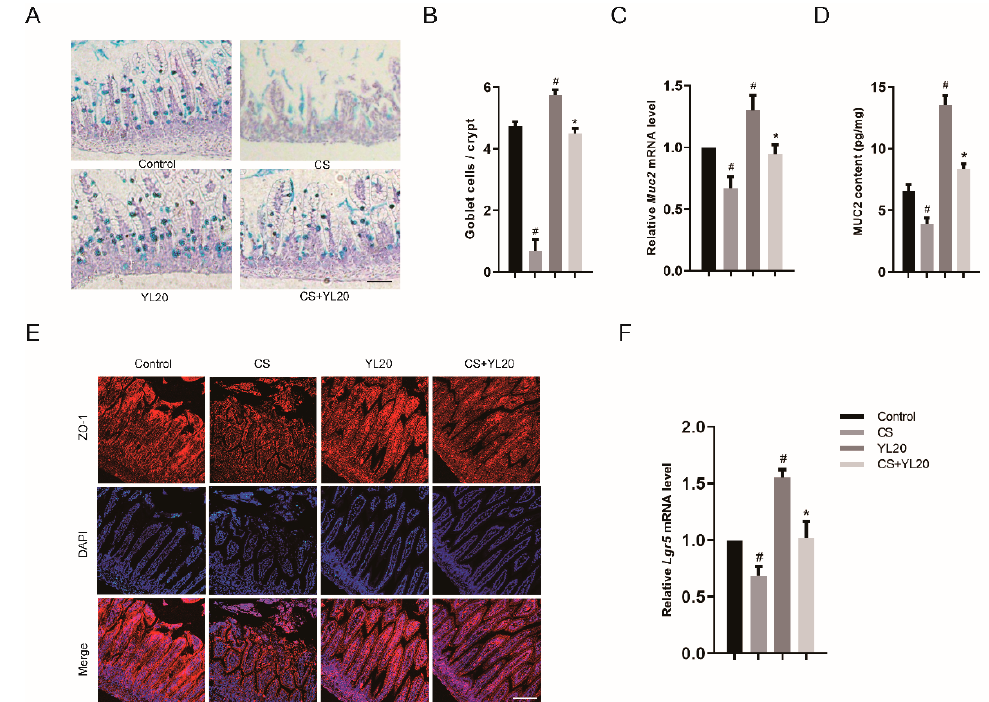
Figure 7. Effects of YL20 administration on intestinal barrier integrity and C. sakazakii -induced intestinal barrier damage. ( A ) PAS staining analysis of C. sakazakii -infected mice pups with or without YL20 administration; scale bar = 100 μ m. ( B ) The number of positively stained cells. ( C ) The mRNA levels of Muc2 in small intestine tissues of pups by RT-PCR. ( D ) The protein levels of MUC2 in small intestine tissues of pups by ELISA. ( E ) Immunohistochemical staining analysis of ZO-1 expression levels in the intestines of mice pups; scale bar = 100 μ m. ( F ) The mRNA levels of Lgr5 in small intestine tissues of mice pups by RT-PCR. # p < 0.05 vs. Control group; * p < 0.05 vs. CS group; n = 3.